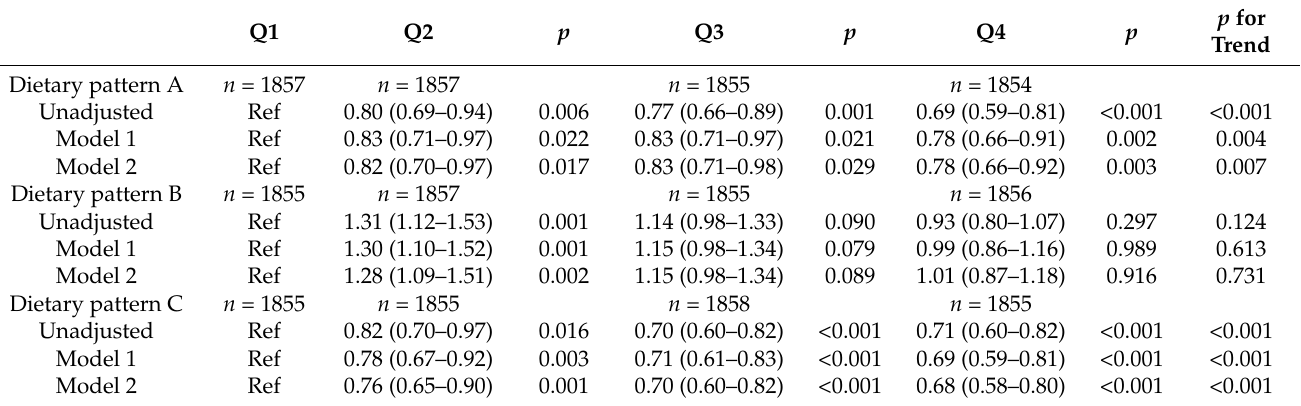
Table 3. Multivariable adjusted ORs and 95% CI of myopia according to quartiles of dietary pattern